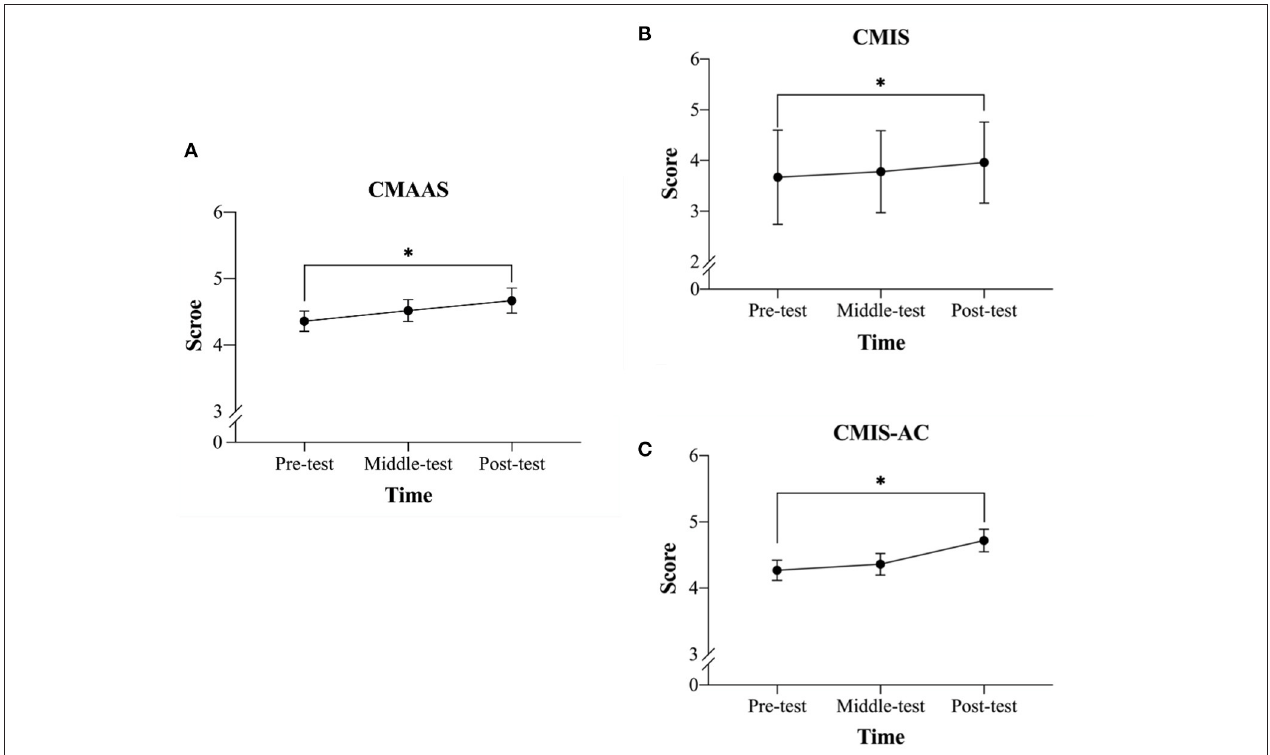
FIGURE 2 | Changes in mindfulness levels across three time points before, at the mid-point of, and after the mindfulness-based peak performance (MBPP) program. (A) Comparison of the scores ( M ± SE) on the Chinese version of the Mindful Attention Awareness Scale (CMAAS) across the three time points, (B) Comparison of the total scores on the Chinese version of the Mindfulness Inventory in Sport (CMIS) scale across the three time points, and (C) Comparison of the scores for the attentional control sub-dimension of the CMIS across the three time points. * p < 0.05.